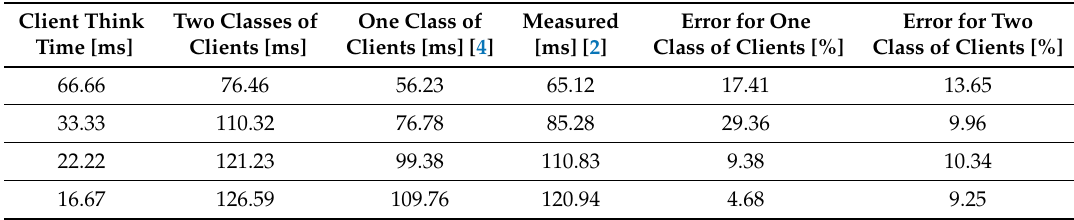
Table 1. Response time error for one and two classes (FE3 and BE1).